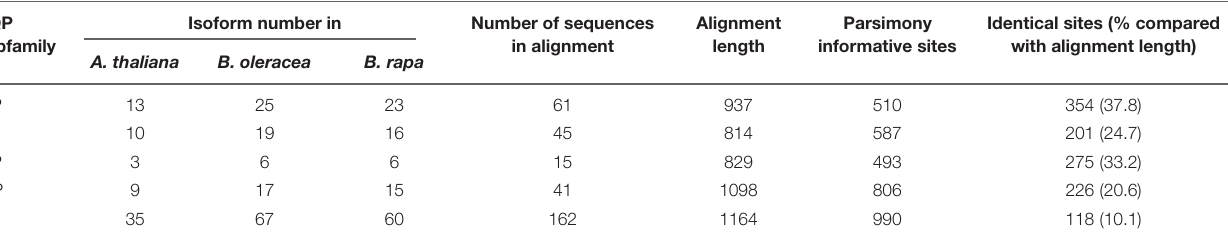
TABLE 3 | Alignment statistics of all Arabidopsis thaliana , Brassica oleracea, and Brassica rapa aquaporin nucleotide sequences. AQP Isoform number in Number of sequences subfamily